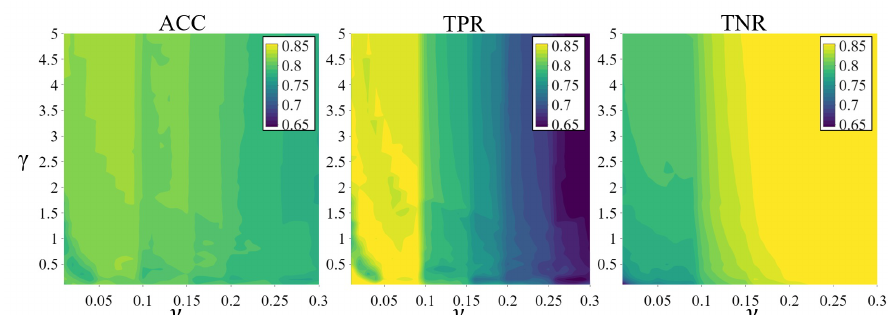
Figure 6. ACC, TPR, TNR as a function of γ and ν for the fixed τ = − 0.1. The yellow color represents the highest rates and the blue color represents the lowest rates.